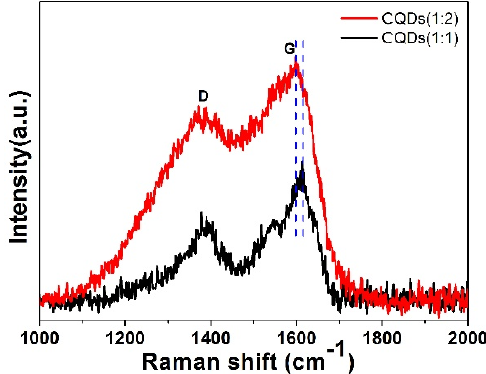
Figure 4. Raman spectra ( λ ex = 514 nm) of CQDs (1:1) and CQDs (1:2).